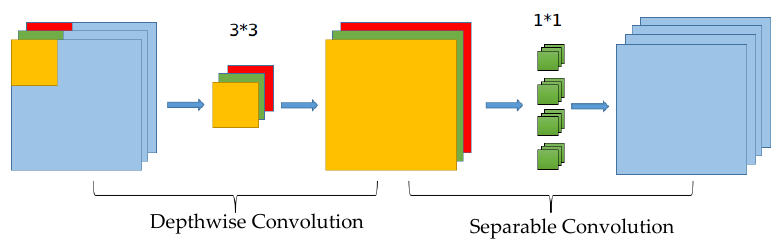
Figure 5. Schematic diagram of separable convolution.